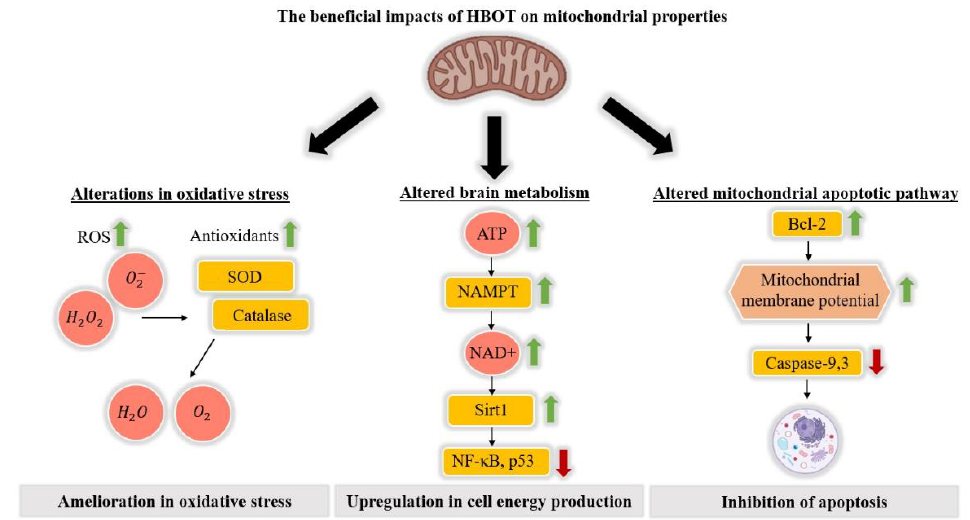
Figure 2. The beneficial impacts of HBOT on mitochondrial properties. Three key processes related to mitochondria that are affected by HBOT- oxidative stress, cell energy production, and apoptosis. Concomitant reduction in the expression of p53 and NF-κB strengthened the fact that an ATP/NAD+/Sirt1 pathway had been activated by HBOT. Furthermore, administration of NAD+ exhibited an effect similar to that of HBOT, and administration of ATP synthase inhibitor, NAMPT inhibitor, or Sirt1 small interfering RNA (siRNA) prevented HBOT‘s positive effect. Activation of this specific pathway by HBOT reduced cell necrosis and improved neurological function [46].